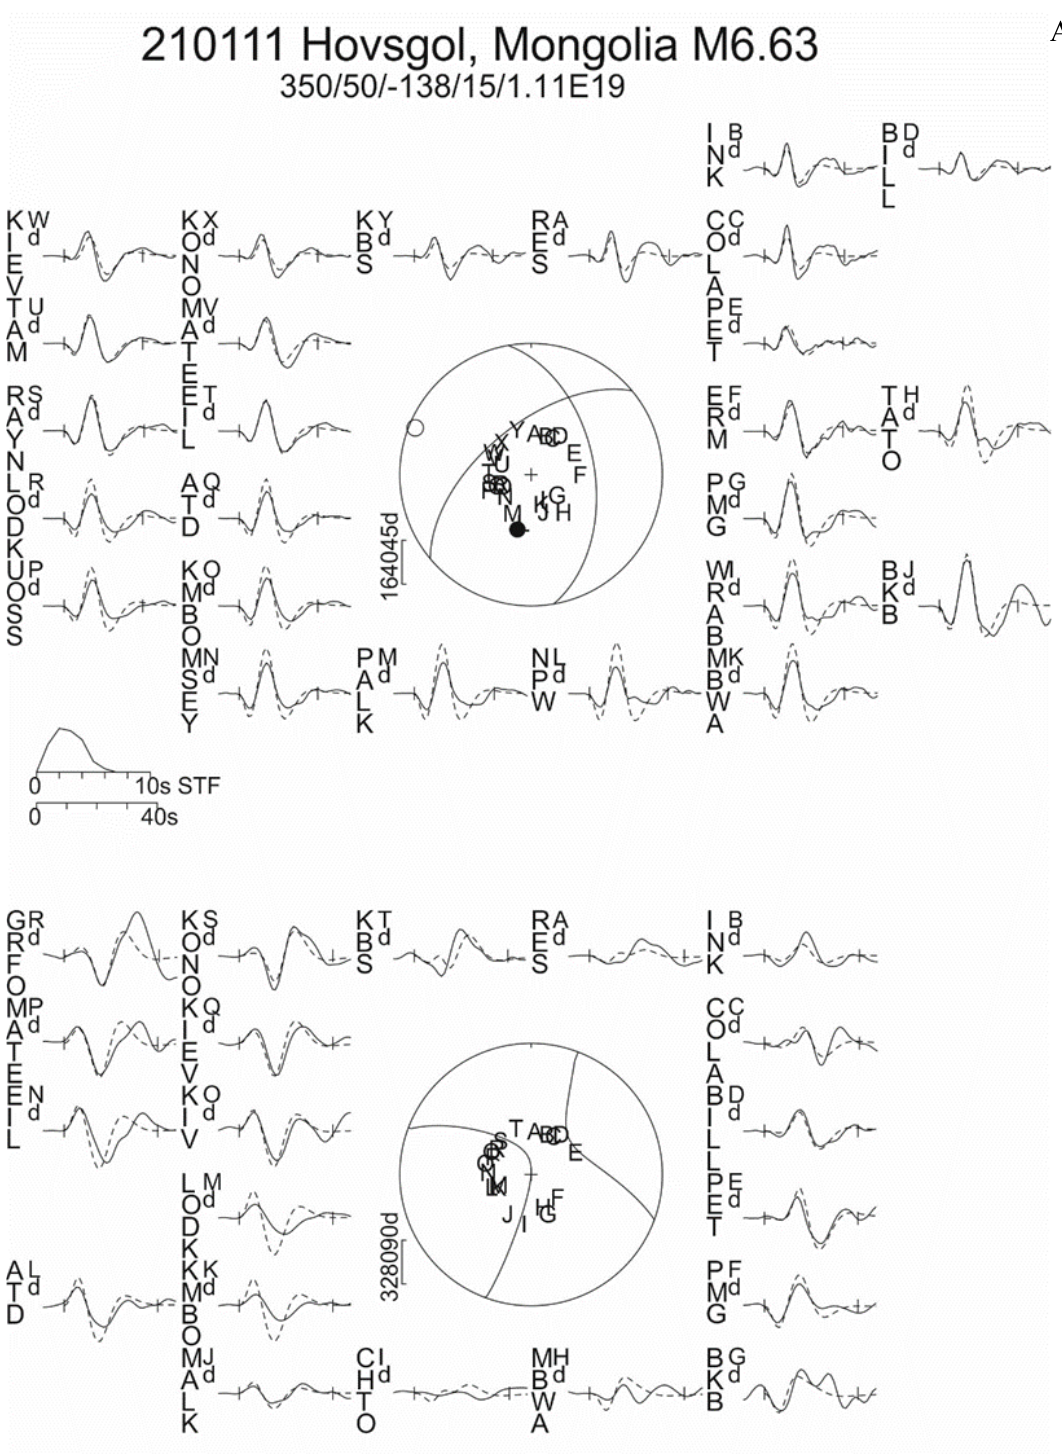
Fig. A1. P and SH waveforms for 210112 Khankh event. The event header shows the strike, dip, rake, centroid depth and scalar seismic moment of the minimum misfit solution. The upper focal sphere shows the lower hemisphere stereographic projection of the P waveform nodal planes, and the positions of the seismic stations used in the modelling routine. The lower focal sphere shows the SH nodal planes. Capital letters next to the station codes correspond to the position on the focal sphere. The solid lines are the observed waveforms, and the dashed lines are the